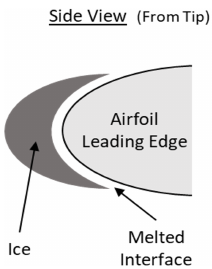
Figure 21. Schematic of melted interface experience from cohesive